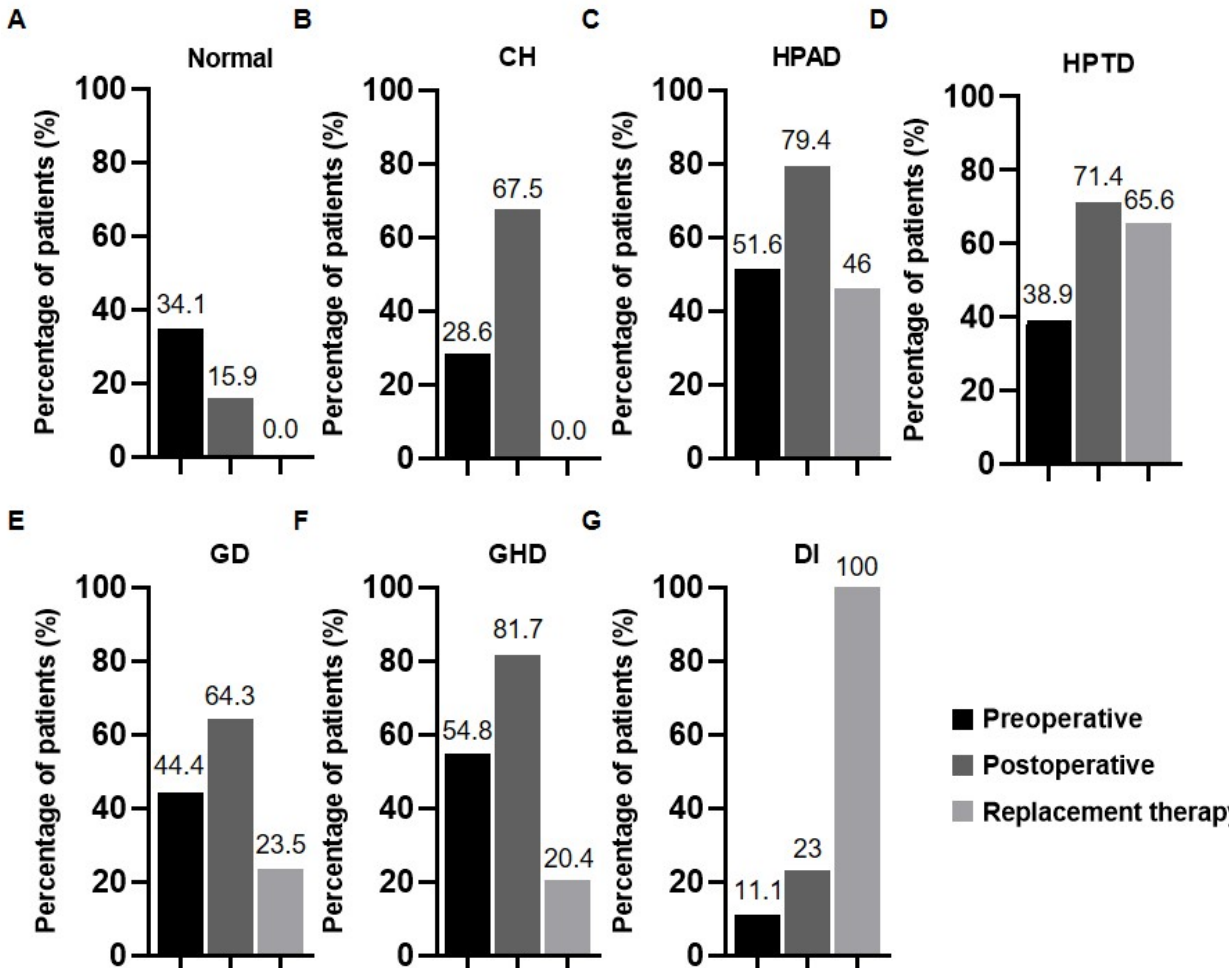
Figure 1. Endocrine deficiencies of the hypothalamic–pituitary axis and replacement therapies in patients with craniopharyngioma. ( A ) The percentage of patients with normal pre- and postoperative pituitary hormone. ( B ) The percentage of patients with pre- and postoperative complete hypopitu- itarism. ( C ) The percentage of patients with pre- and postoperative hypothalamic–pituitary–adrenal axis deficiency, as well as the percentage of patients with replacement treatment. ( D ) The percentage of patients with pre- and postoperative hypothalamic–pituitary–thyroid axis deficiency, as well as the percentage of patients with replacement treatment. ( E ) The percentage of patients with pre- and postoperative gonadotrophin deficiency axis deficiency, as well as the percentage of patients with replacement treatment. ( F ) The percentage of patients with pre- and postoperative growth hormone deficiency, as well as the percentage of patients with replacement treatment. ( G ) The percentage of patients with pre- and postoperative diabetes insipidus, as well as the percentage of patients with replacement treatment. CH: Complete hypopituitarism, HPAD: Hypothalamic–pi-